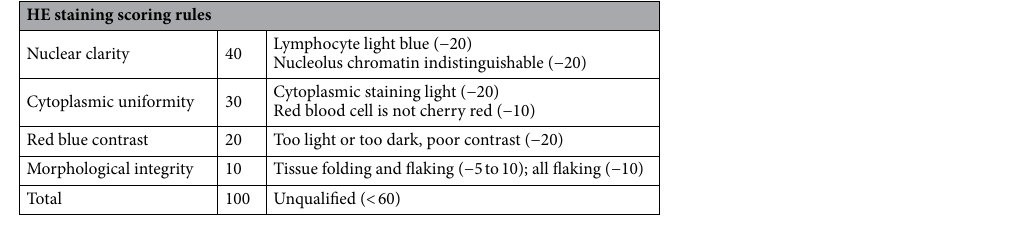
Table 2. HE staining scoring